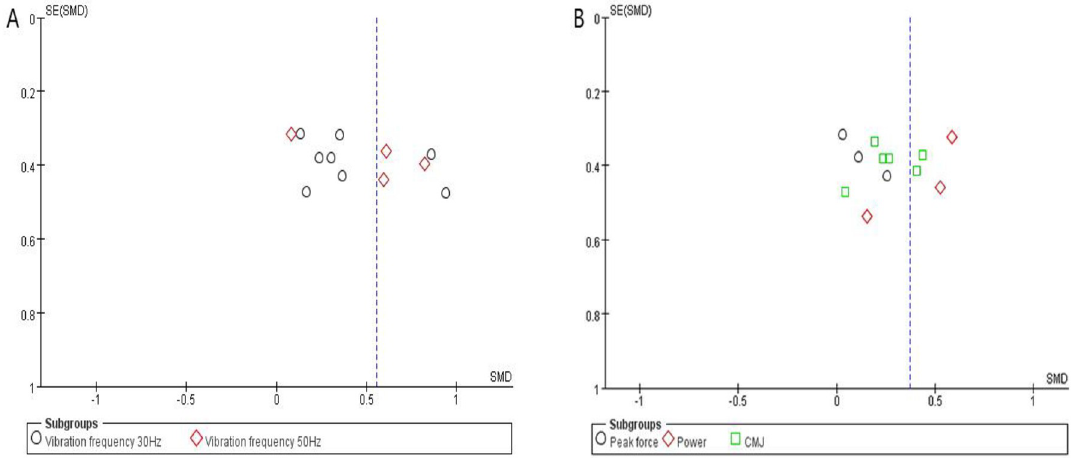
Fig 3. Funnel plots of included studies. (A) Neuromuscular activation post vibration versus previbration. (B) Explosive power post vibration versus previbration.